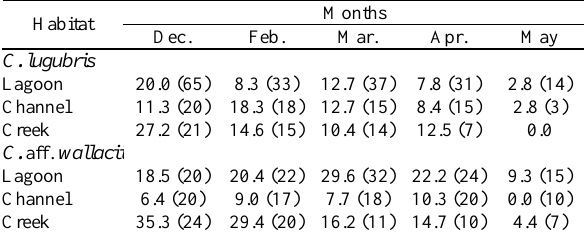
Table 3. Percentages of empty stomachs recorded for Crenicichla lugubris and Crenicichla aff. wallacii in three habitats for the Cinaruco River during five consecutive months. Number of individuals examined for each month appears in